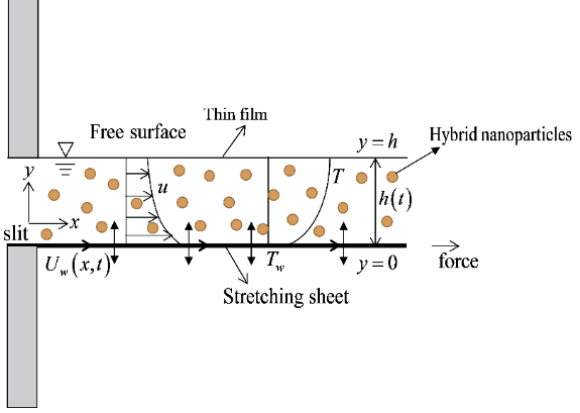
Fig. 1. Physical schematic